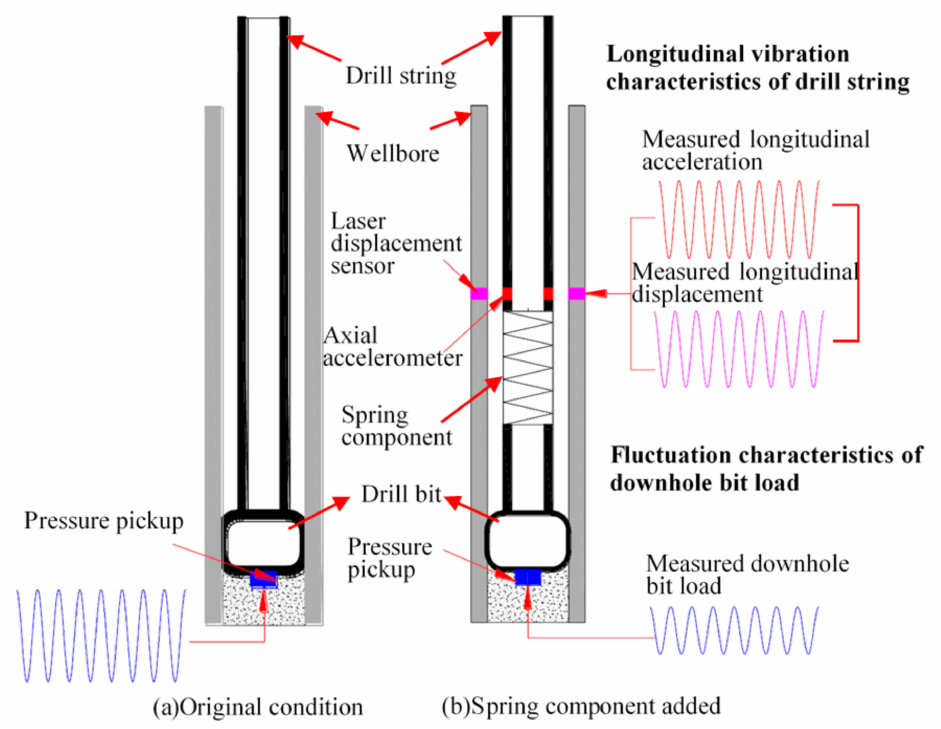
Figure 1. Physical model and its experimental